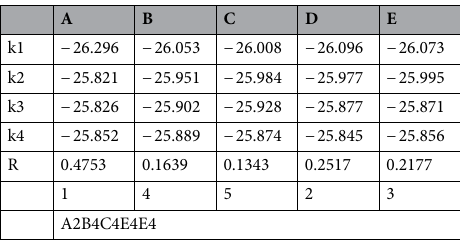
Table 11. Range Analysis of Integrated SNR.